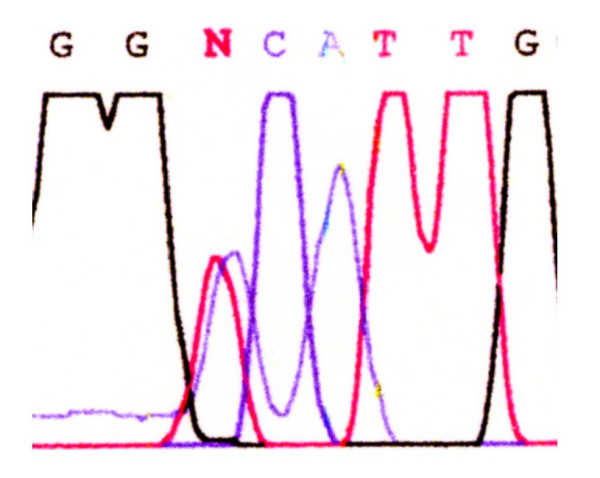
Genomic sequencing of the PDGFRA gene. Direct sequencing analysis showing a point mutation at codon 561 (GTC to GAC) in exon12. Val561 is changed to Asp.